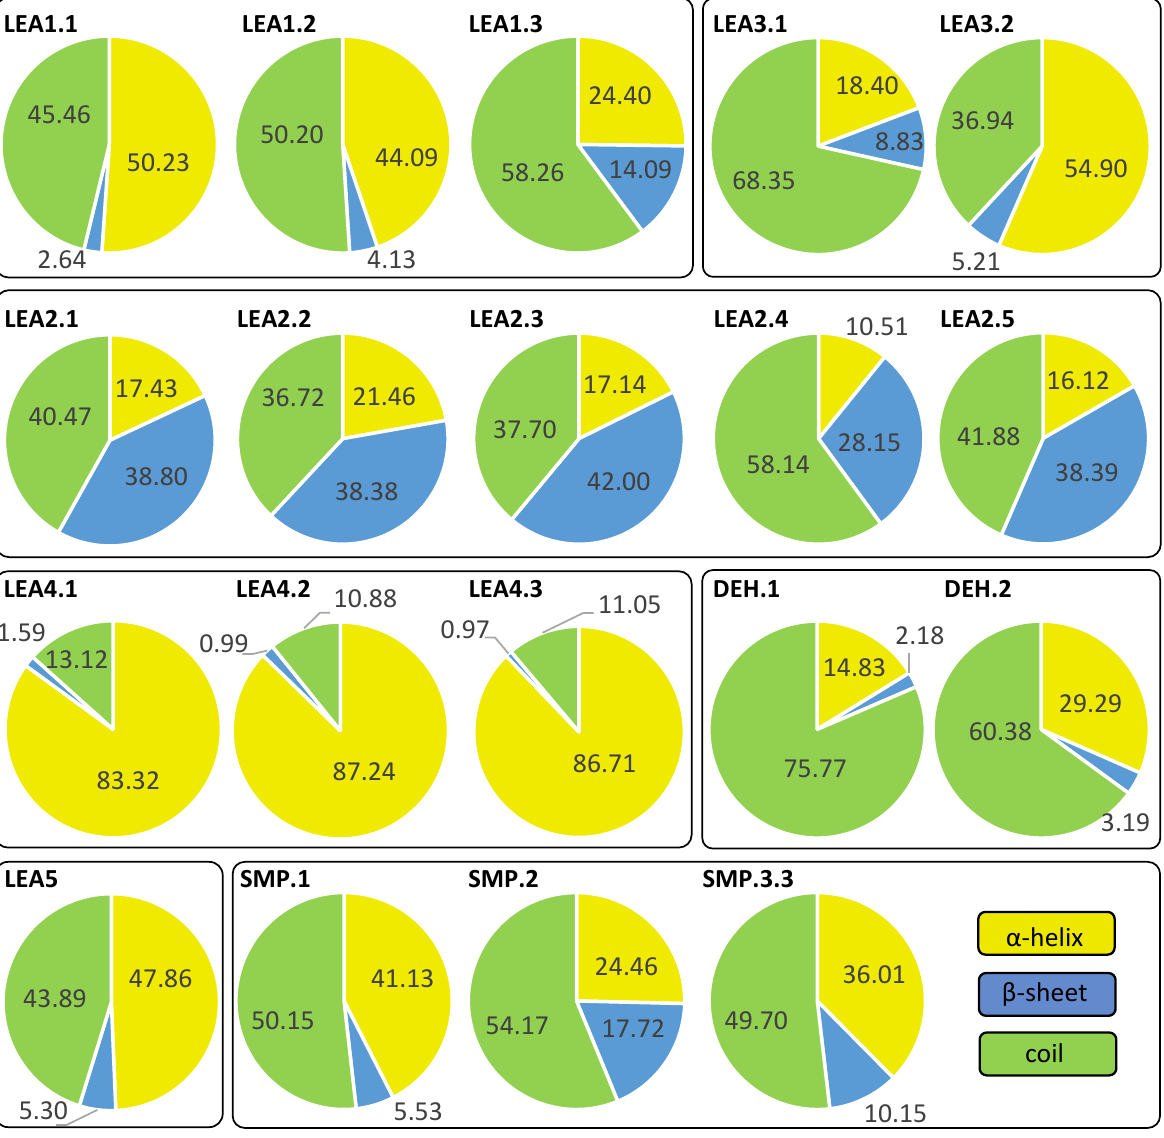
Figure 3. Average distribution of the predicted secondary structure of each R. serbica LEA protein family group and subgroup members according to the five secondary structure prediction algorithms: PsiPred, Sopma, FELLS, Phyre2, and JPred4.